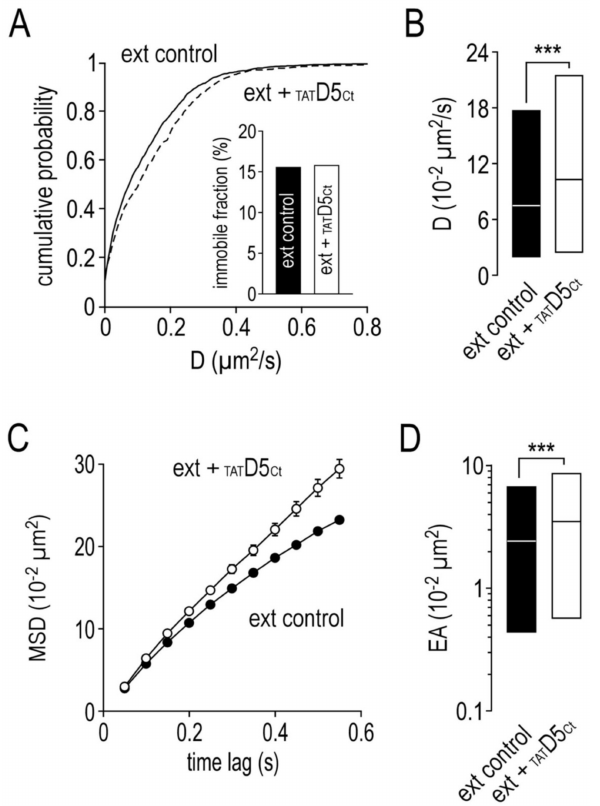
Figure 8. The disrupting peptide impairs the surface dynamic properties of extrasynaptic dopamine D5 receptors. ( A ) Cumulative probability diffusion coefficient of extrasynaptic dopamine D5 receptors in control condition or in the presence of the disrupting peptide (10 µ M). The inset shows the immobile fraction (defined as D < 0.005 µ m 2 /s) of extrasynaptic dopamine D5 receptors in control condition and in the presence of the disrupting peptide. ( B ) Bar graphs illustrating the instantaneous diffusion coefficient (D, represented as median ± interquartile range 25–75%) of extrasynaptic dopamine D5 receptors in control condition or in the presence of the disrupting peptide. ( C ) Comparison of extrasynaptic dopamine D5 receptors mean square displacements (MSD, represented as mean ± SEM) in control condition or in the presence of the disrupting peptide. ( D ) Bar graphs illustrating the explored surface area (EA, represented as median ± interquartile range 25–75%) of extrasynaptic dopamine D5 receptors in control condition or in the presence of the disrupting peptide. *** p < 0.001. Nonparametric Mann–Whitney